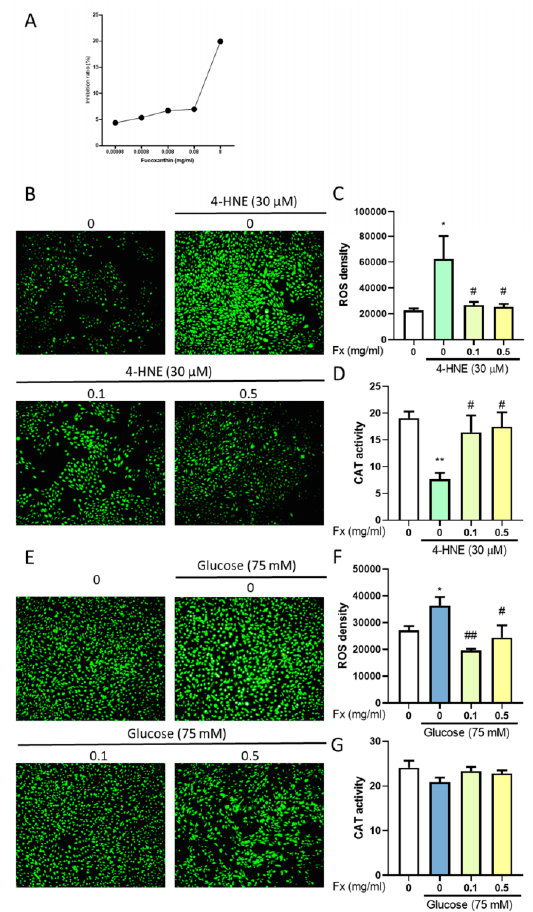
Figure 7. E ff ects of fucoxanthin (Fx) on 4-HNE- and high glucose-induced ARPE19 antioxidant ability change. ( A ) We used a 2,2-diphenyl-1-picrylhydrazyl (DPPH) assay to evaluate the antioxidant ability of fucoxanthin. Treated with 4-HNE to measure the DCFHA fluorescence ( B ) image, ( C ) level, and ( D ) antioxidant enzyme activity or high glucose-induced oxidative DCFHA fluorescence ( E ) image, ( F ) level, and ( G ) antioxidant enzyme activity change. ARPE19 cells were cultured in DMEM F12 for 24 h after serum free starvation for 18 h. This was combined with fucoxanthin induced by 30 µ M 4-hydroxynonenal (4-HNE) for 24 h or 75 mM glucose for 72 h ( n = 3–5). *, p < 0.05; and **, p < 0.01 compared with the non-treated group. #, p < 0.05; and ##, p < 0.01 compared with the induced group (4-HNE 30 µ M / glucose 75 mM). We used a microscope at 10 ×